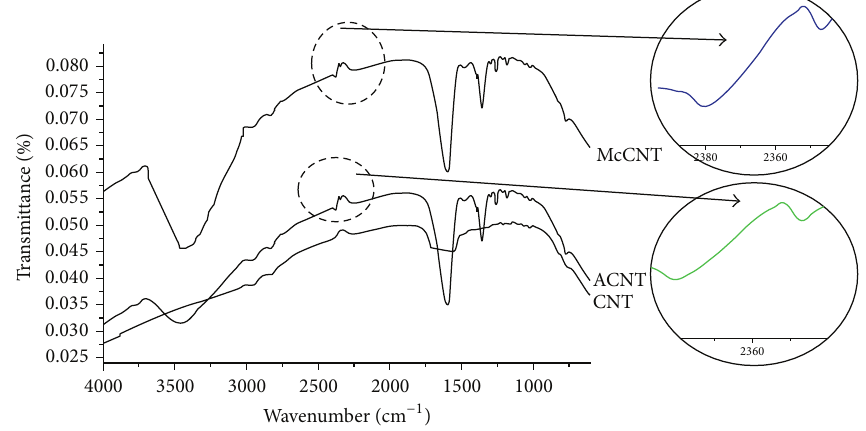
Figure 1: FTIR spectrum of pristine and treated CNTs.